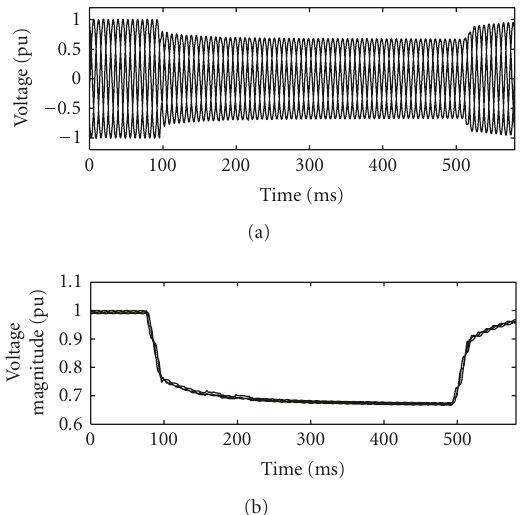
Figure 12: Voltage dip due to fault, with the influence of induc- tion motor load during a fault: (a) voltage waveforms; (b) voltage magnitude (measurement in an 11 kV network).